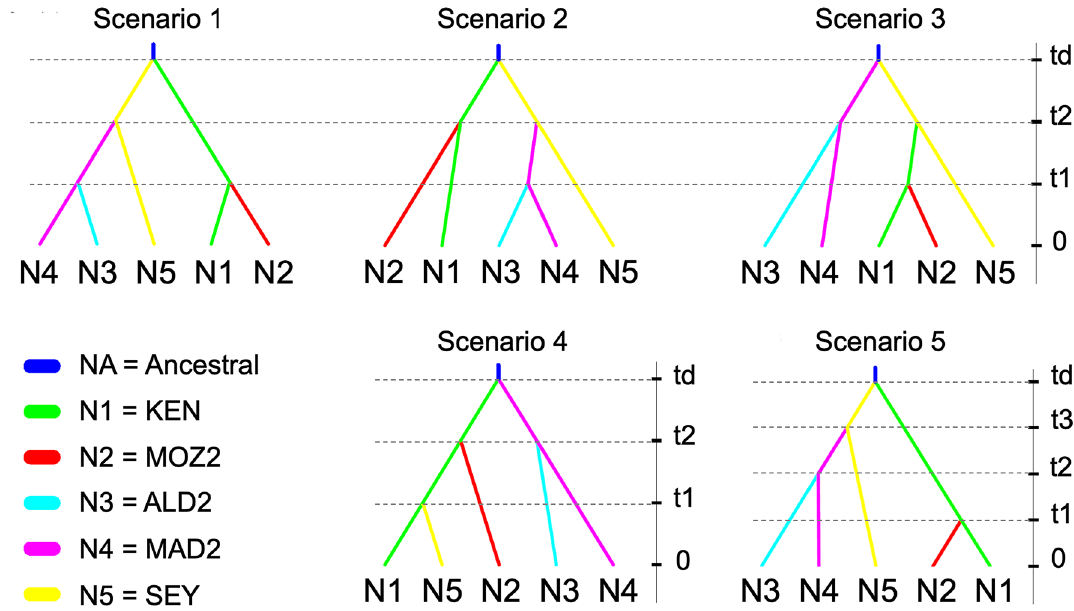
Figure 5. The five scenarios tested for an approximate Bayesian computation (ABC) model implemented in DIYABC ver. 2.0. Five populations with effective population sizes N1 to N5 correspond to KEN, MOZ2, ALD2, MAD2 and SEY, respectively. Scenario 1 represents an early divergence of both the Seychelles and coastal East Africa group with more recent divergence of the Madagascar and Aldabra group; scenario 2 represents an early divergence of both Seychelles and Kenyan populations with more recent divergence of both the Madagascar- Aldabra group and Mozambique Channel Area (MCA) population; scenario 3 represents an early divergence of both the Seychelles and Madagascar populations with a more recent divergence of both the Aldabra population (from Madagascar) and the coastal East Africa group (Kenya and MCA); scenario 4 represents an early divergence of both Madagascan and Kenyan populations with more recent divergence of both the Aldabra and MCA populations, though with the Seychelles as the most recent group originating from East Africa; and scenario 5 includes three period levels with an early divergence of the Seychelles and East Africa group, though with subsequent stepping-stone dispersal from the Seychelles towards Madagascar and then further to Aldabra. NA is the ancestral effective population size and t# represent subsequent time events (not drawn to scale). Scenario 3 considering an early divergence of both Seychelles and Madagascar gave the highest probability.